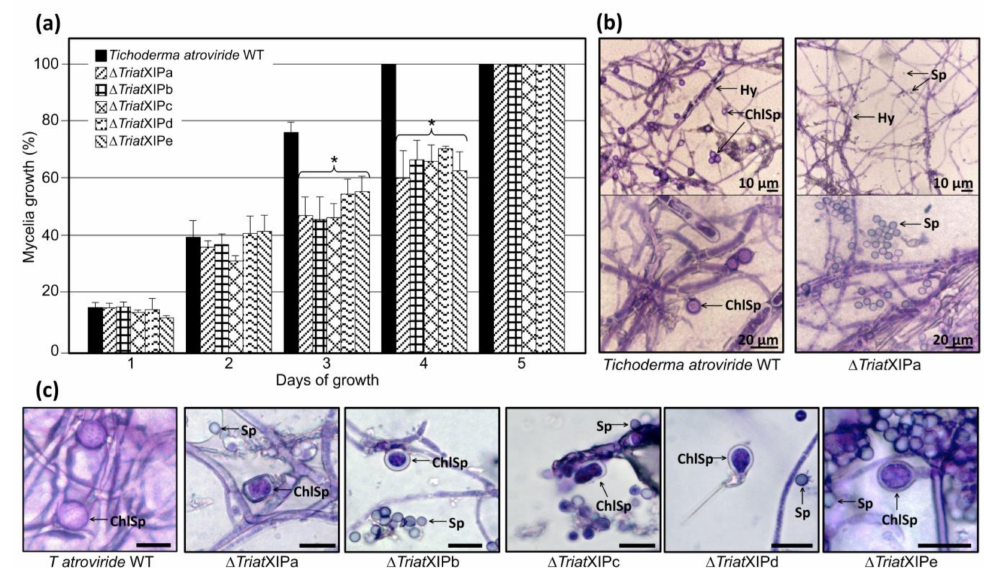
Figure 3. Phenotypes of T. atroviride wild type and the five ∆ Triat XIP mutants upon growth on PDA medium. ( a ) The mycelial growth corresponds to the mean of three independent biological experiments, and bars represent the biological standard deviation. *, Data are statistically significantly different between the wild type and each transformant, as verified by one-way ANOVA analysis followed by Tukey’s post hoc test ( p < 0.05). ( b ) Light microscopy of hyphae and spores of the parental strain and the ∆ Triat XIPa mutant for illustration after 20 days of cultivation on PDA media in darkness at 23 ◦ C. The scale bar represents 10 or 20 µ m. Samples were colored with toluidine blue (1% w / v ) for 1 min prior to the observations. ChlSp, Chlamydospores; Sp, spores; Hy, hyphes. Each ∆ Triat XIP are shown in Figure S10. ( c ) Example of morphology of Chlamydospores (ChlSp) and conidiospores (Sp) from the parental strain and the five ∆ Triat XIP mutants after 14 days of cultivation on corn flour medium (corn flour 62.86 g/L, glycerol 7.54 mL/L, pH 4.2) in darkness at 23 ◦ C. The scale bar represents 10 µ m. Samples were colored with toluidine blue (1% w / v ) for 1 min prior to the observations by light